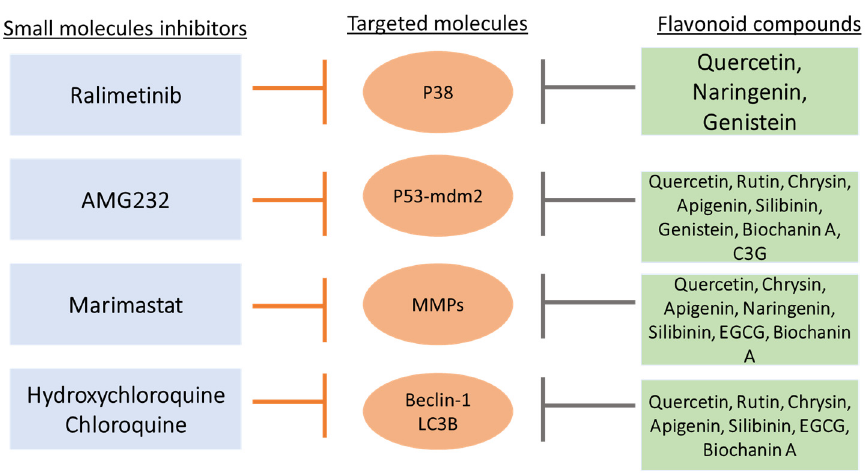
Figure 3. Common molecular targets of small molecule inhibitors and flavonoid compounds.